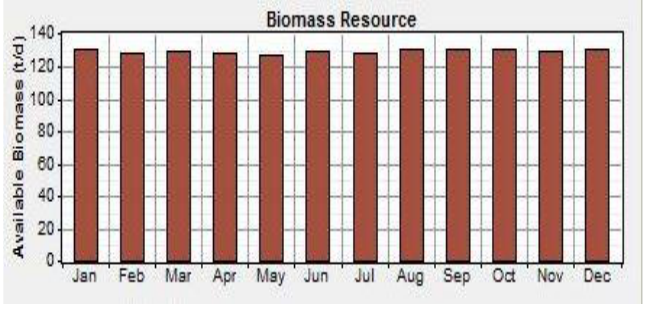
Fig. 4. Biomass availability [27]